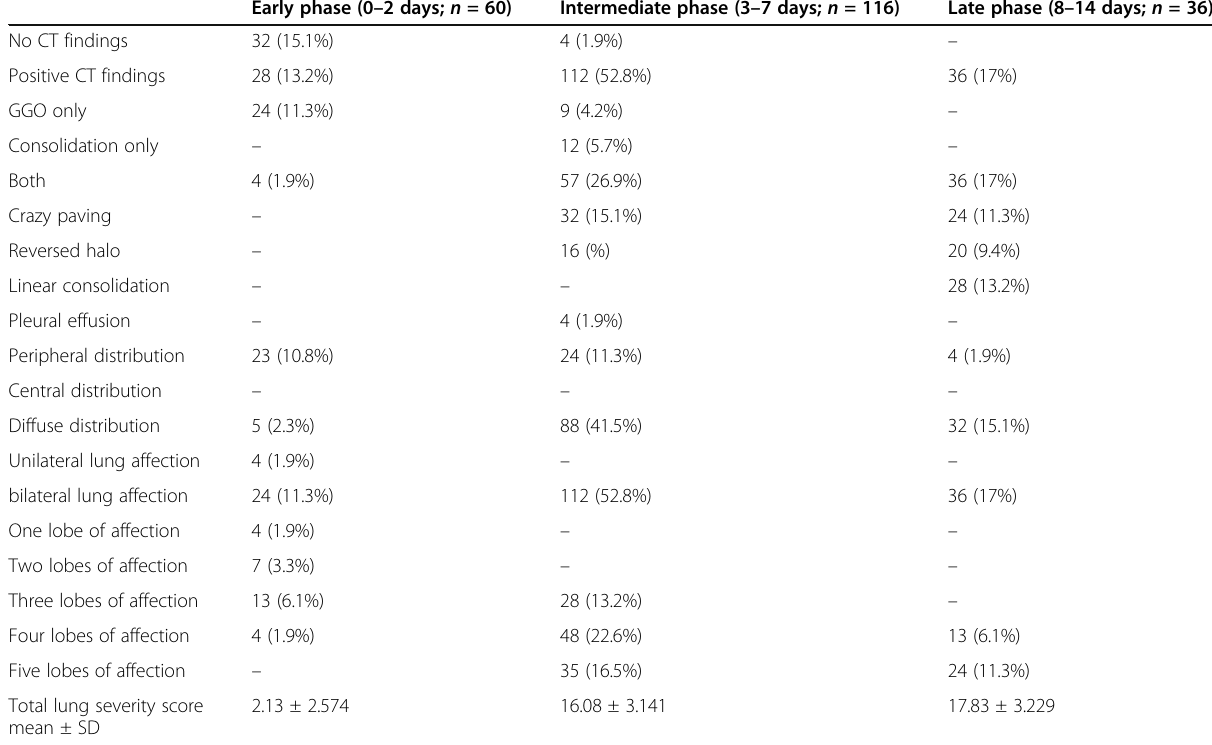
Table 2 Distribution and frequency of the CT pulmonary abnormalities at different phases